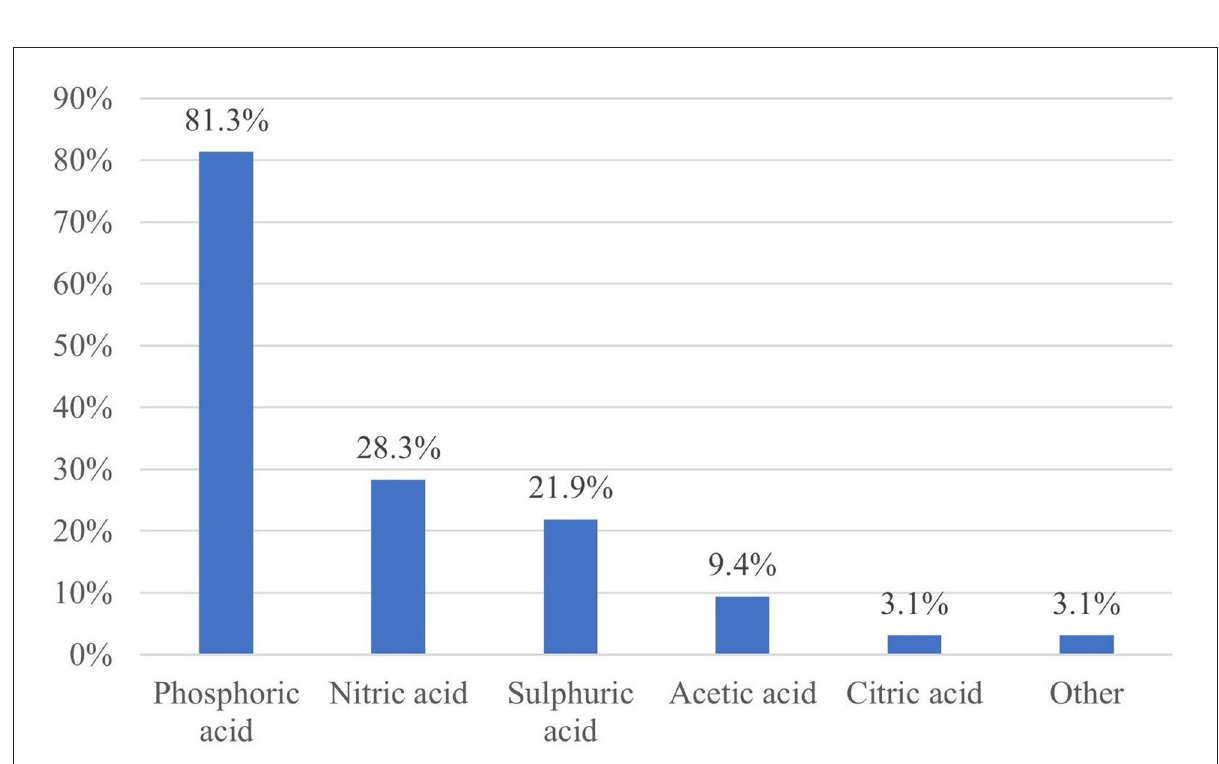
FIGURE5 Active ingredients of the acid washes ( n =